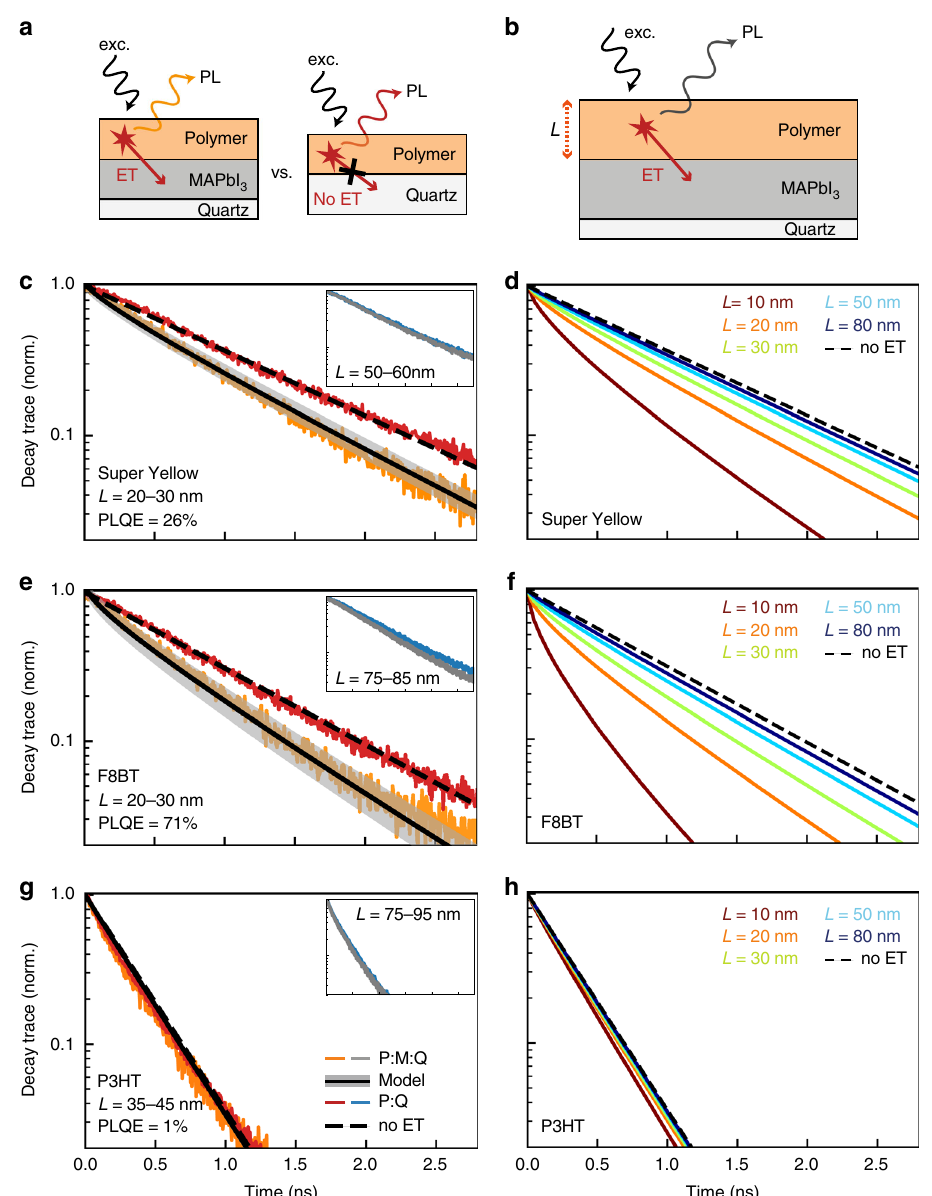
Fig. 1 PL transients revealing energy transfer between polymer and MAPbI 3 thin fi lms. a Samples examined were either thin fi lms of polymers deposited on MAPbI 3 fi lms on quartz (schematic diagram on the left) or polymers deposited directly on quartz to serve as references (schematic diagram on the right). ET may occur between the polymer and the MAPbI 3 layer, leading to PL quenching, as depicted schematically in b . The left column shows time- resolved PL transients as a function of time after excitation for polymers c Super Yellow, e F8BT and g P3HT, when deposited as fi lms of thickness L on either MAPbI 3 :quartz (orange lines) or just on quartz (red lines). The dashed lines are monoexponential fi ts to the data, yielding the PL lifetime of each polymer on quartz in the absence of ET (lifetime values provided in Supplementary Table 4). The solid black lines are fi ts to data based on an ET model described in the main text, with the grey shaded area indicating the error margin. The insets show equivalent data for thicker polymer fi lms on either MAPbI 3 :quartz (grey lines) or just on quartz (blue lines). The right column depicts the expected PL-decay traces for polymers d Super Yellow, f F8BT and h P3HT for different fi lm thickness L , as determined from the ET model. PL transients for the scarcely emitting PTAA samples are provided as Supplementary Fig.